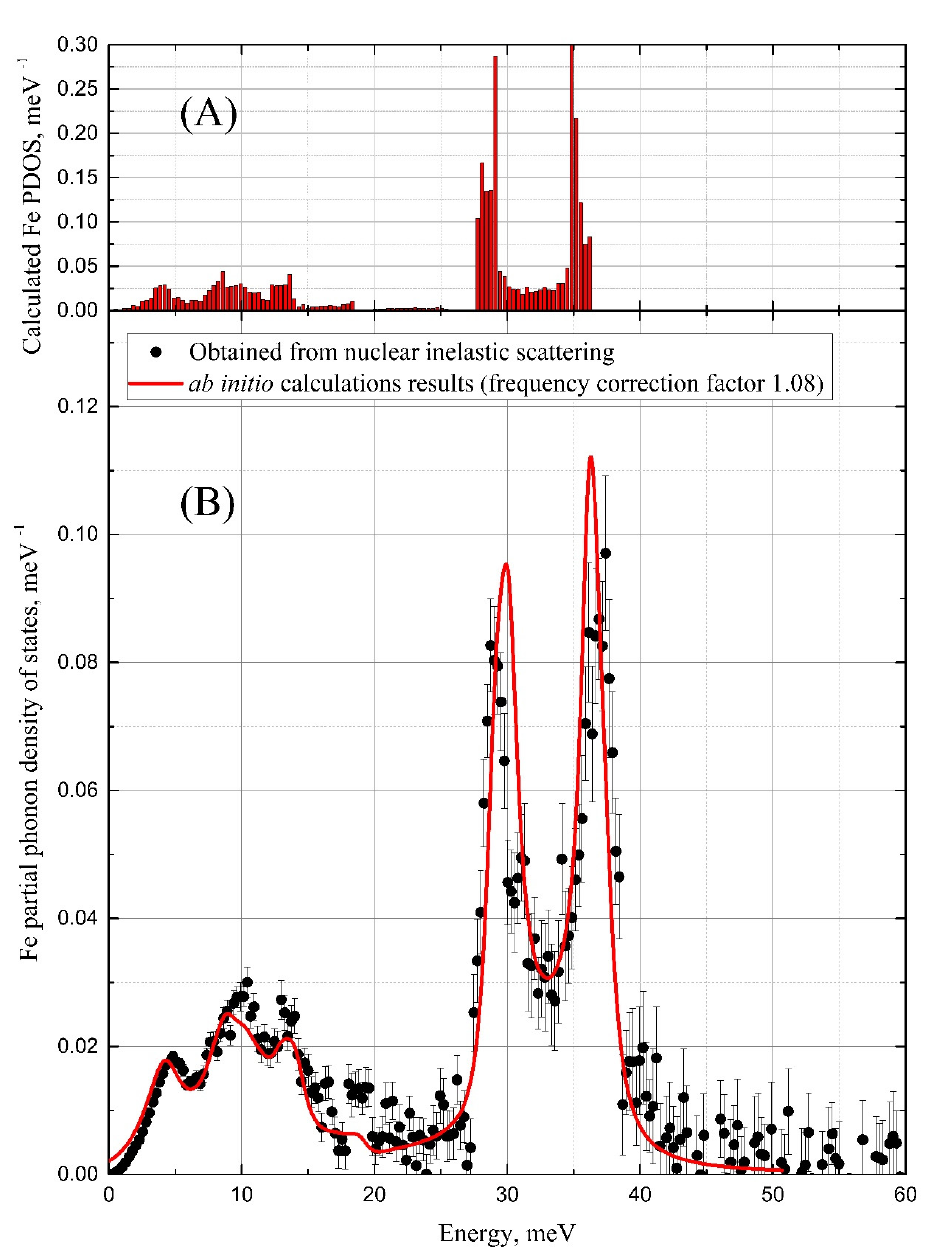
Figure 2. ( A ) Calculated phonon density of states (PDOS) for iron ions in RbFeSe 2 [3]; ( B ) Partial PDOS for iron atoms of RbFeSe 2 obtained from the nuclear inelastic scattering spectrum (black dots) and from ab initio PDOS smoothening by the Gaussian profile (red line, see description in the body text). The ab initio calculations were carried out within the framework of density functional theory (DFT) utilizing the Vienna ab initio simulation package (VASP 5.3) [15–18]. The Perdew–Burke– Ernzernhof (PBE) generalized gradient approximation (GGA) was applied for the exchange and correlation corrections [19]. The projector-augmented wave (PAW) method is used to take into account the electron-ion interactions. The PAW method is a frozen-core one in which the valence Rb